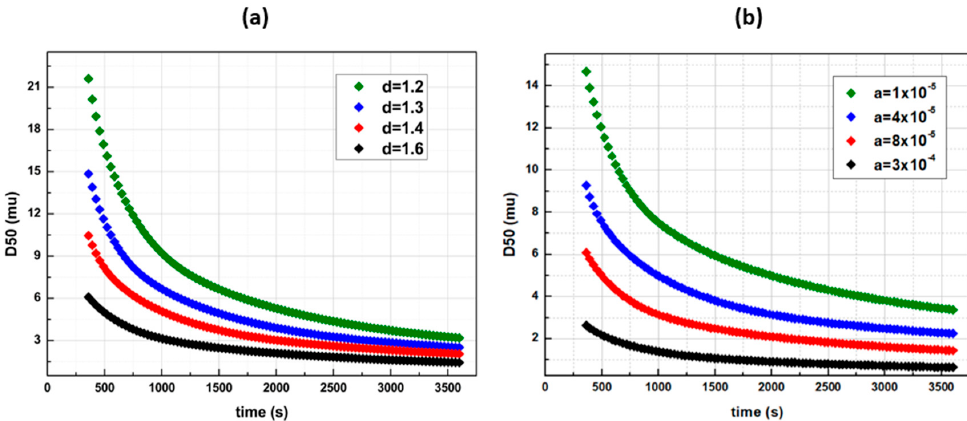
Figure 6. D50 time profiles with Austin’s breakage function in various a and d parameter values with γ = 1.17 and ϕ = 0.3 ( a ) a = 8 × 10 − 5 and ( b ) d =